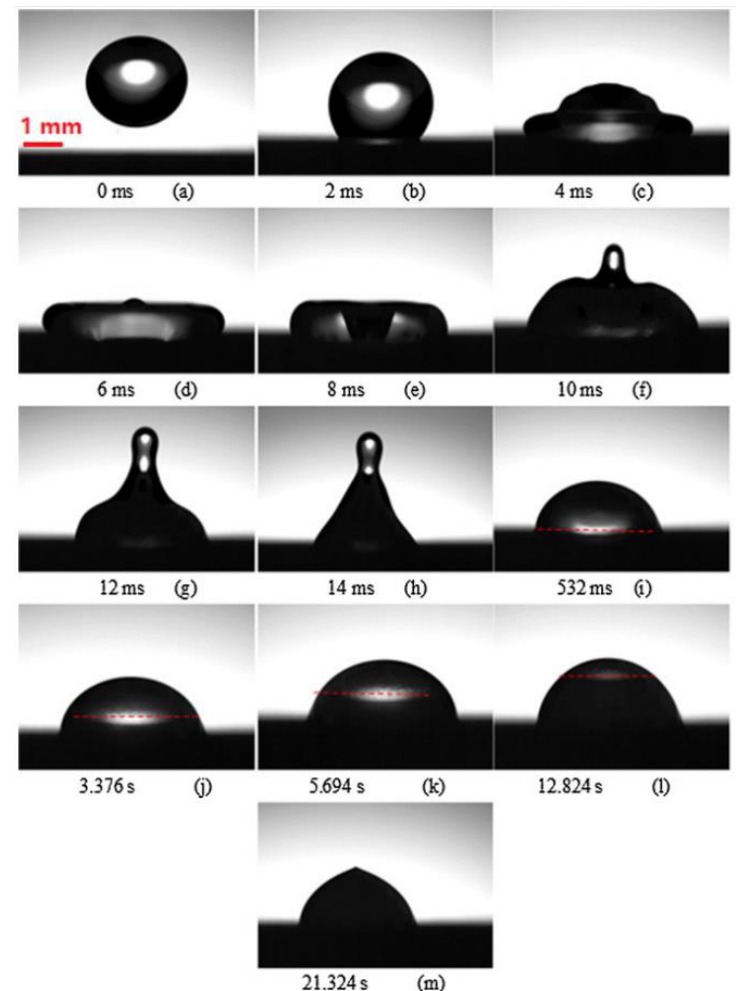
Figure 4. Sequences of water droplet impact on a cold hydrophobic surface, in a way ( a – m ): the starting point of the process to the end of the phenomenon. Droplet diameter = 2.82 mm, impact velocity = 0.77 m/s, and surface temperature = −10 °C (reproduced with permission from [68]).